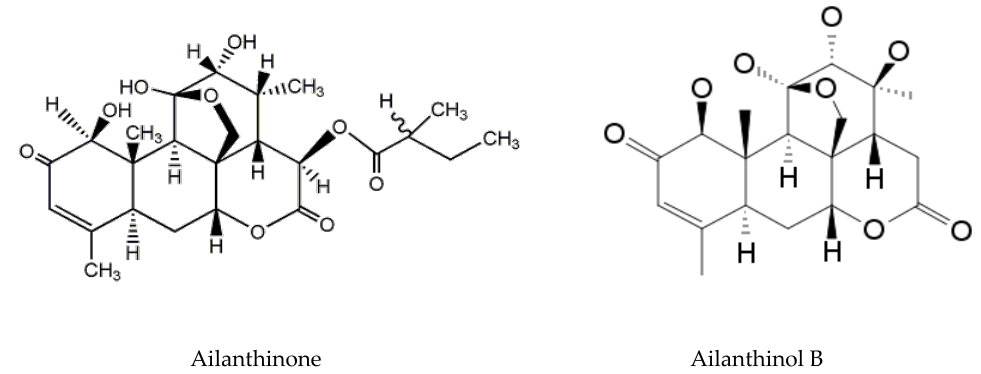
Figure 2. Allelochemicals of Ailanthus altissima .